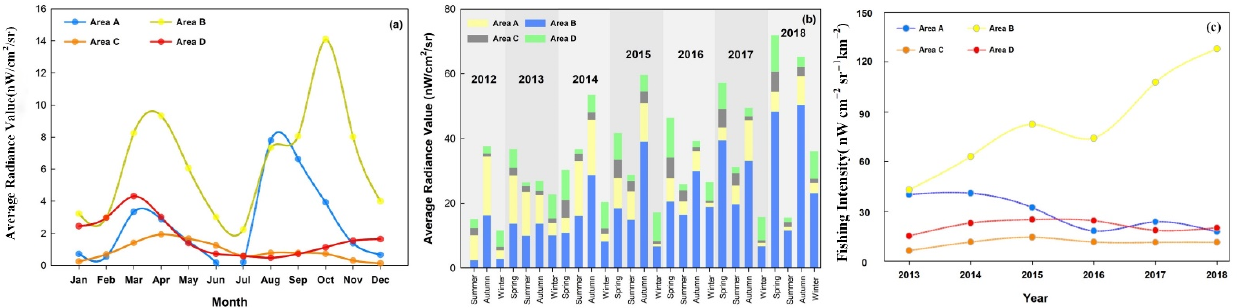
Figure 12. The total of light radiance across the entire SCS: ( a ) monthly results, ( b ) annually-averaged results.